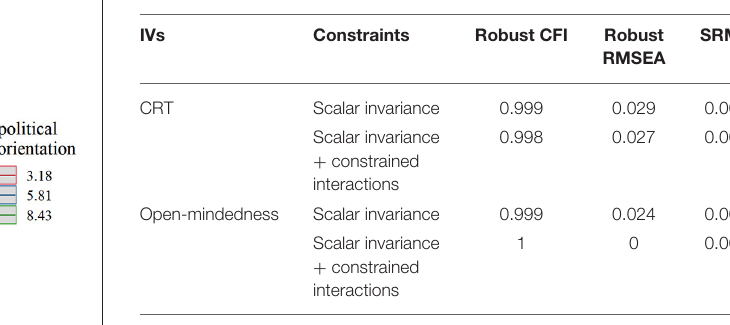
TABLE 7 | Invariance of interactions of political orientation with CRT and open-mindedness across the two countries: Canada and the